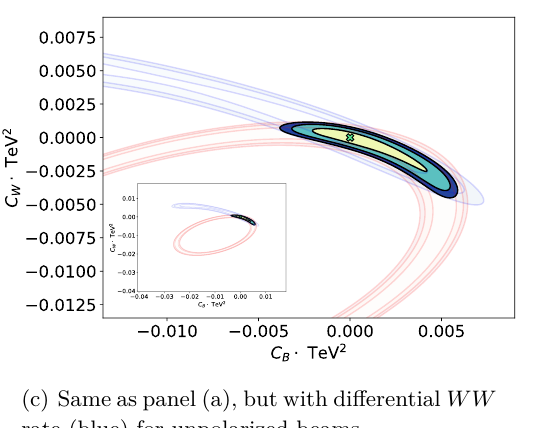
√ Figure 4 . χ 2 profiles in the ( C B , C W ) plane at a s = 10 TeV muon collider. The four panels combine different inclusive and differential measurements with polarized and unpolarized beams. Solid filled contours are for the combination of the χ 2 relevant for each panel. The iso-lines are for ∆ χ 2 values equivalent to 67%, 95%, and 99% confidence level. For completeness of display, we add the inset in the lower-left corner to show the same quantities on a bigger